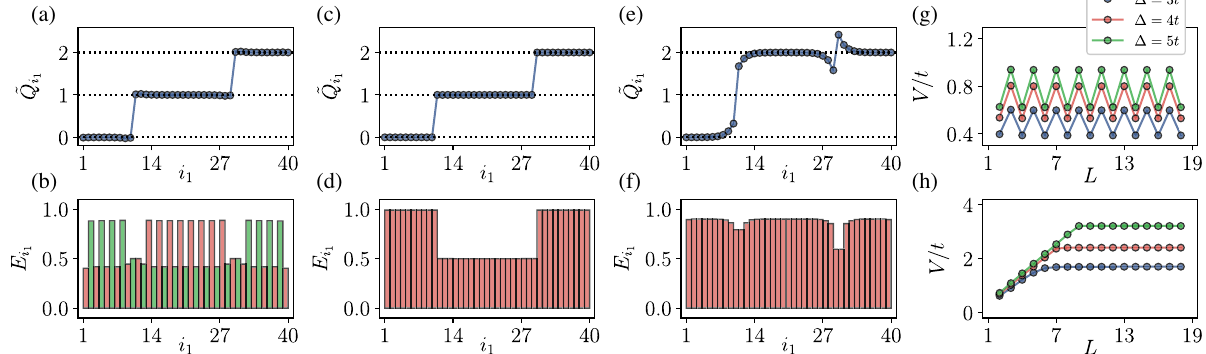
FIG. 10. Deconfinement versus string breaking. Panels (a) – (f) represent the ground-state configuration corresponding to a ladder of 40 at half-filling with two extra static charges located in the upper leg and separated by L ¼ 20 sites, with h ¼ 0 . 2 t . length N s ¼ (a) Integrated total charge Q in the even-charge sector for Δ ¼ 3 t , showing two jumps of height one at the location of the static charges. i (b) Each static charge creates a defect electric field to satisfy Gauss law. (c) Same as before but for the imbalanced sector with Δ ¼ 10 t . (d) In this case, an electric string develops between the charges. Panels (e) and (f) depict how, for Δ ¼ 3 t and in the imbalanced sector, a particle-antiparticle pair is created in the vacuum to screen the static charges, breaking the original string between them. (g) Potential energy V=t between the two static charges as a function of the distance x between them, for different values of Δ , in the even-charge sector. (h) A similar calculation in the imbalanced